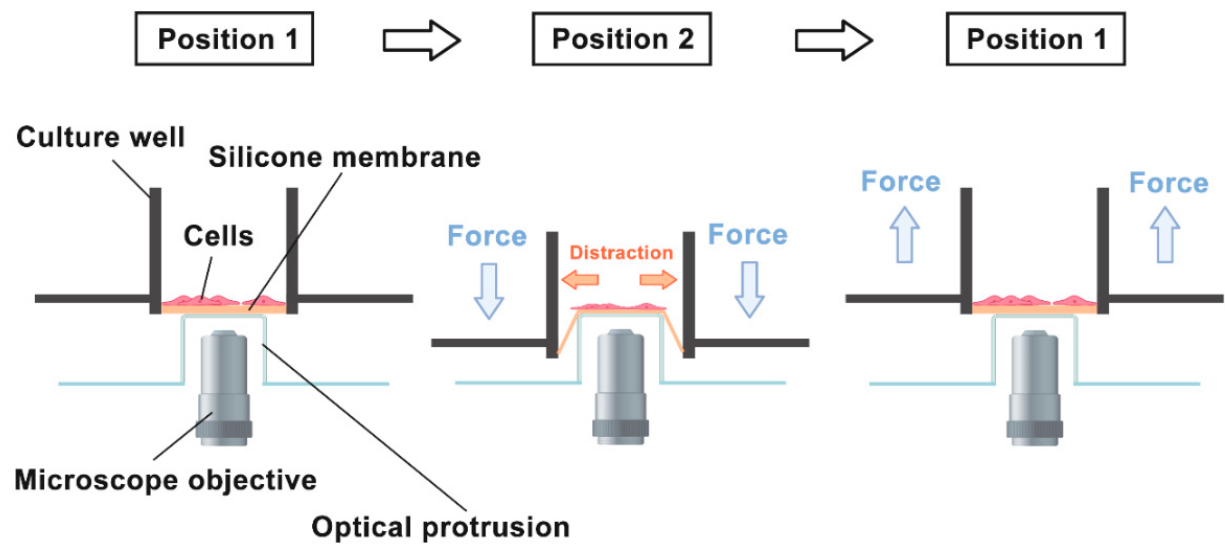
Figure 9. The schematic of self-designed distraction device. It is developed based on an inverted microscope for the purpose of real-time observation. Being mounted over the objective is an optical protrusion, on the top of that is a silicone membrane, holding hBMSCs in a culture well. There was cyclic force pressing (to position 2) or lifting (to position 1) the culture well sinusoidally, which made the silicone membrane stretched on the optical protrusion. The distraction was then transducted from the membrane into the intracellular parts of hBMSCs.